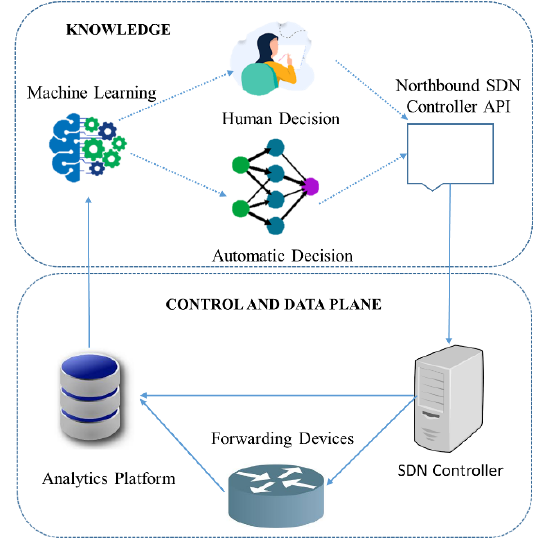
Figure 2. Basic operation of SDN-with-knowledge.